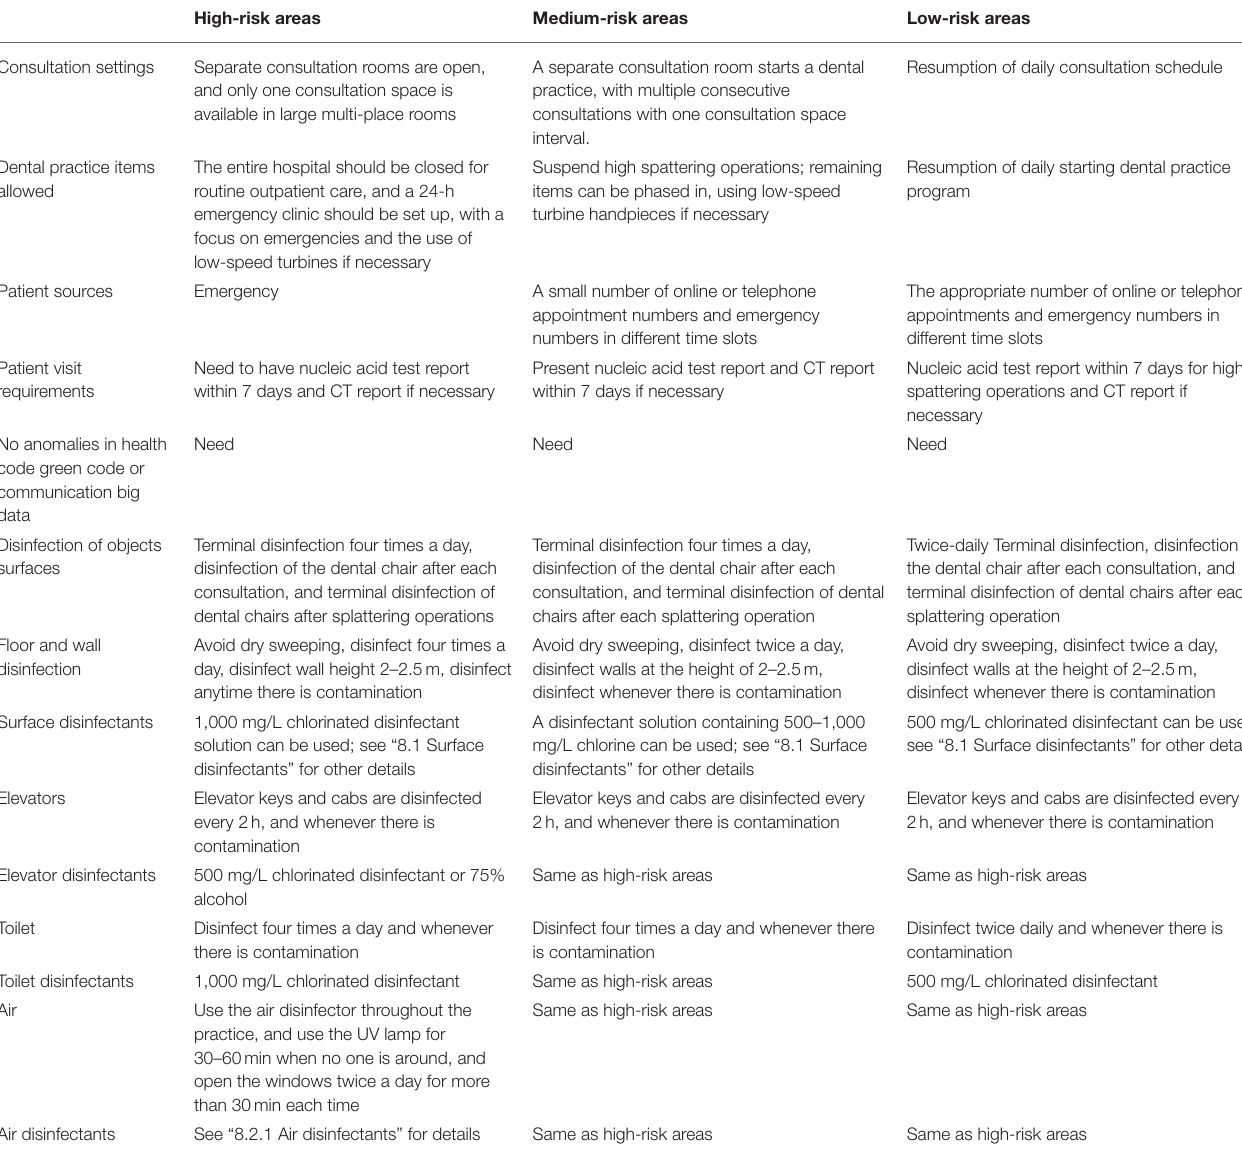
TABLE 2 | Hierarchical differential guidelines for dental institutions to start